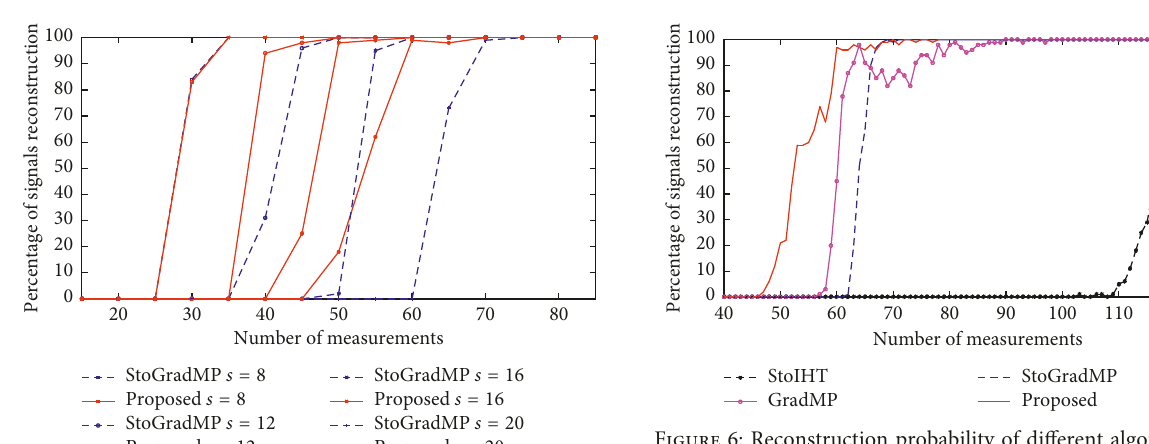
256, s 20, t 0.6, Gaussian signal). (cid:31) (cid:31) (cid:31)